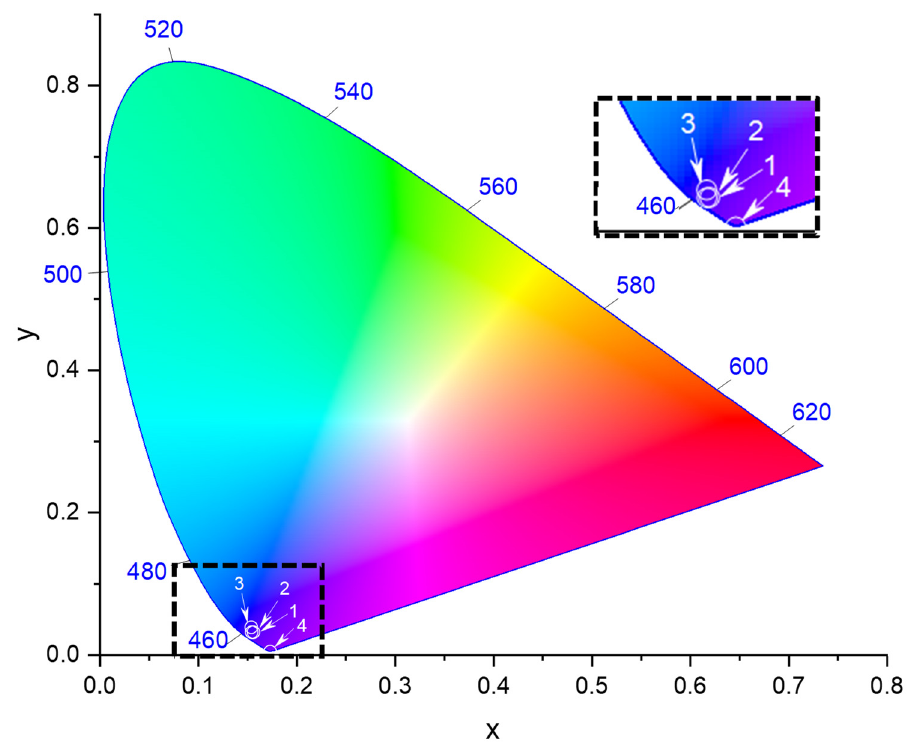
Figure 9. Representation of the emission color of complexes 1 – 4 within the CIE 1931 chromaticity diagram.